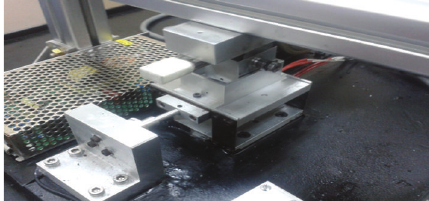
Figure 2: Lubricant bath for specimen facilitates the linear move-